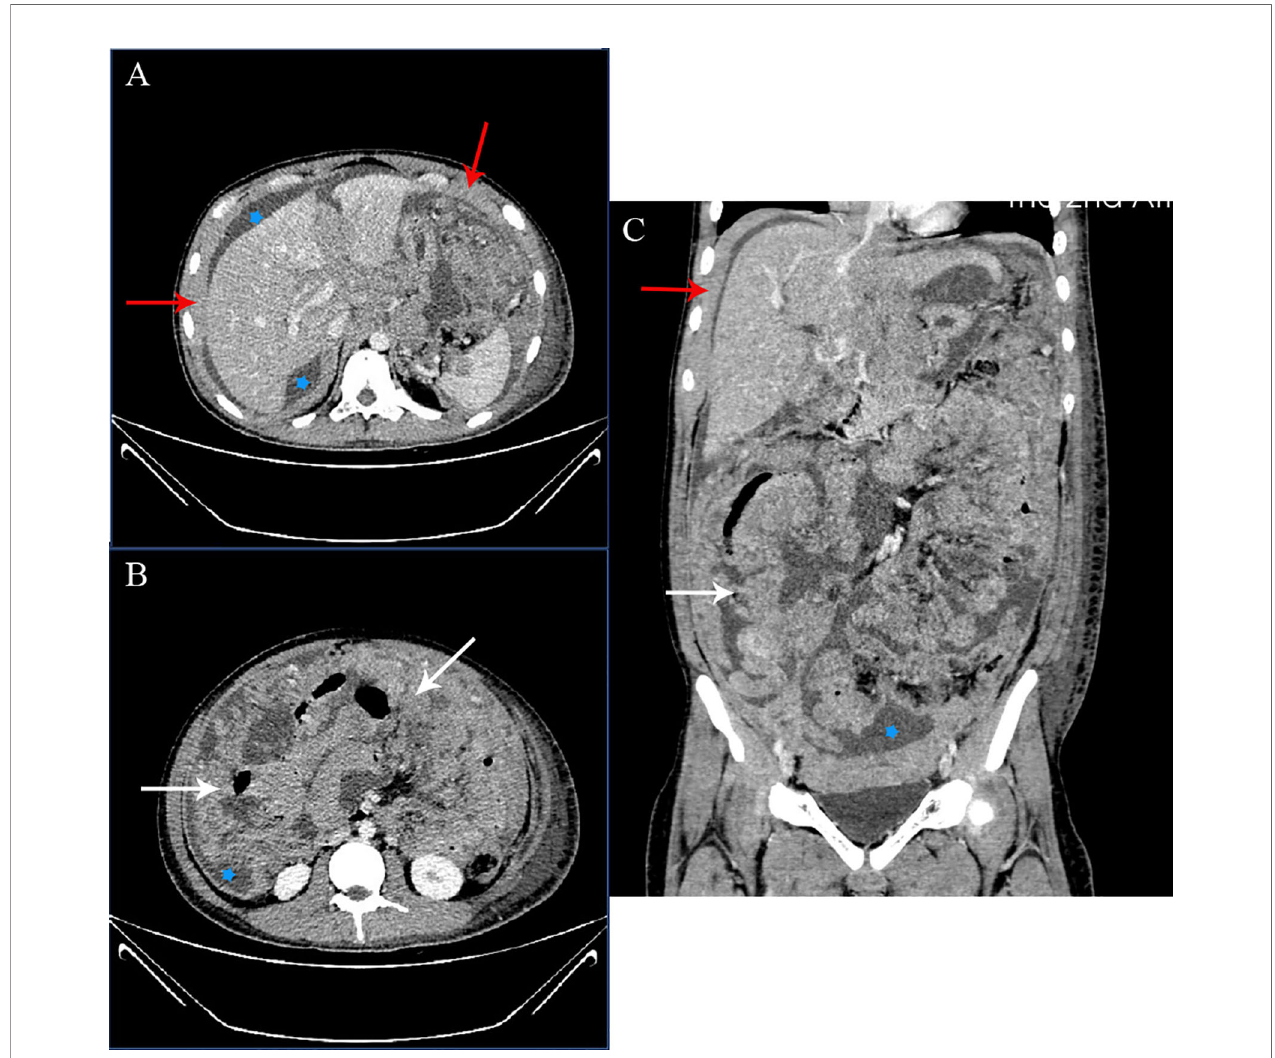
FIGURE 1 | CT examination before-treatment. Axial (A) , Axial (B), and coronal (C) enhanced CT images of the abdomen and pelvis in the portal phase. Extensive ascites (stars), thickening of the peritoneum (red arrow), and marked thickening of the omentum (white arrows) noted. No enlarged lymph nodes were